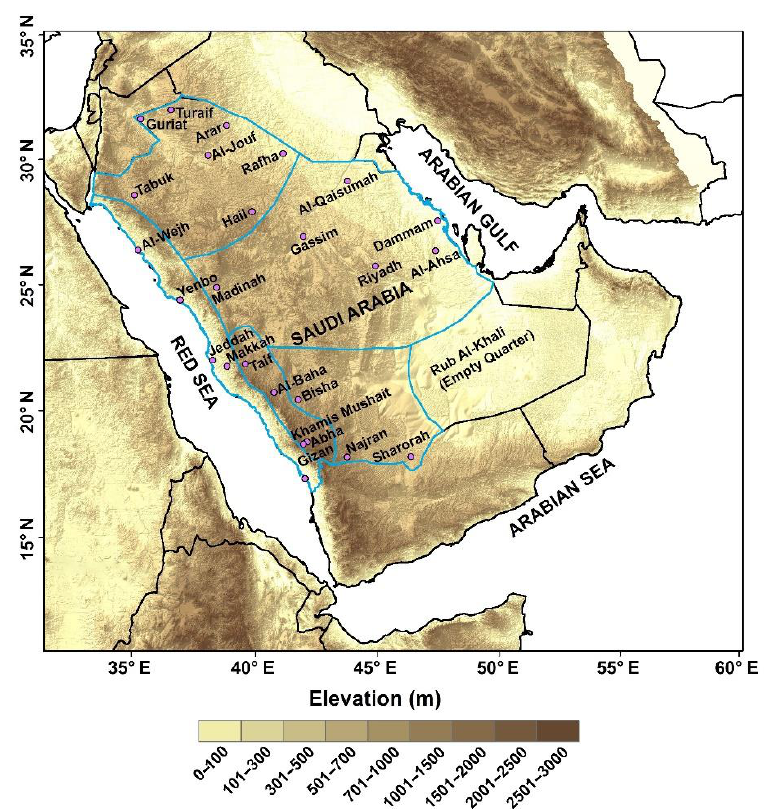
Figure 1. Regional map with surface elevation (m) in and around Saudi Arabia. The 25 meteorological station locations across Saudi Arabia (see Table 1) are shown with closed circles. The solid blue lines indicate the five climatic regions—northern (Turaif, Gurait, Arar, Al-Jouf, Rafha, Tabuk, and Hail), coastal (Wejh, Yenbo, Jeddah, Makkah, and Gizan), interior (Al-Qaysumah, Gassim, Dammam, Al-Ahsa, Madinah, Riyadh), highland (Taif, Al-Baha, Abha, and Khamis Mushait), and southern (Bisha, Najran, and Sharorah)—in Saudi Arabia, adapted from Almazroui et al. [41].